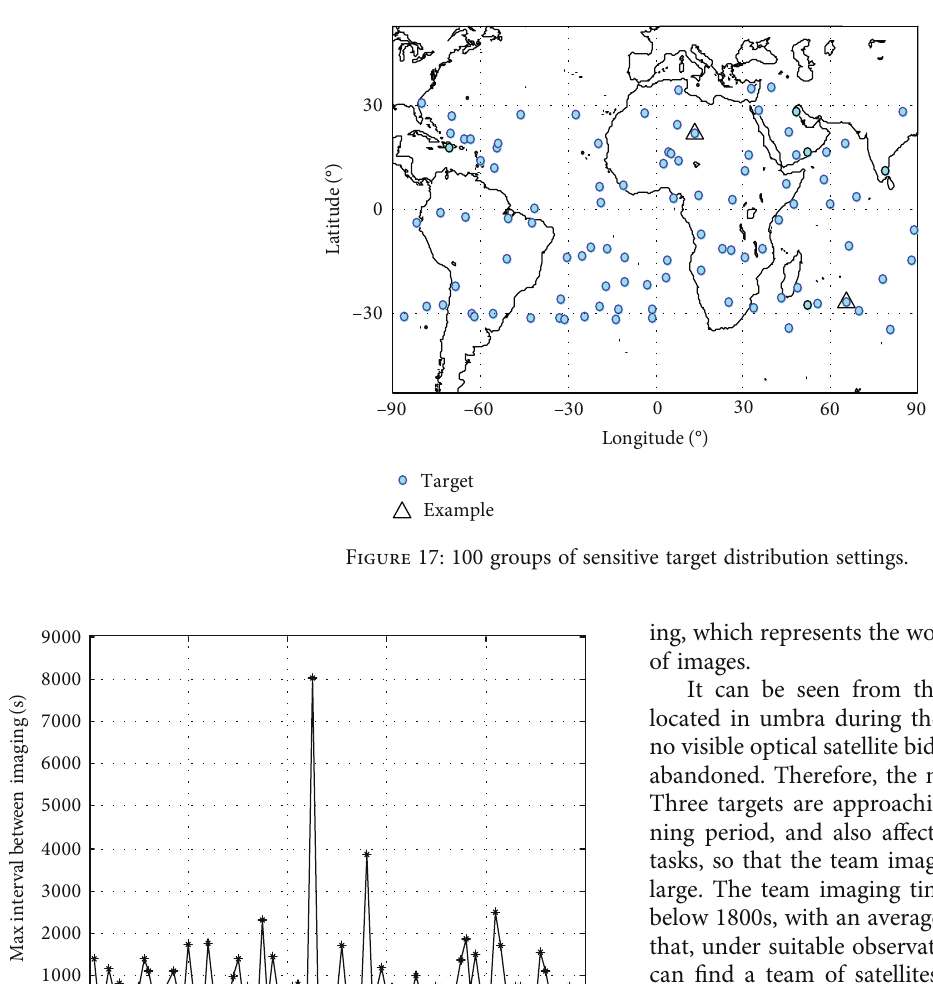
e ff ectiveness of all team bidding results. The evaluation criteria are the shortest task response time and the shortest team imaging process time. After three times of bidding, the bid-link result is represented in Figure 16.